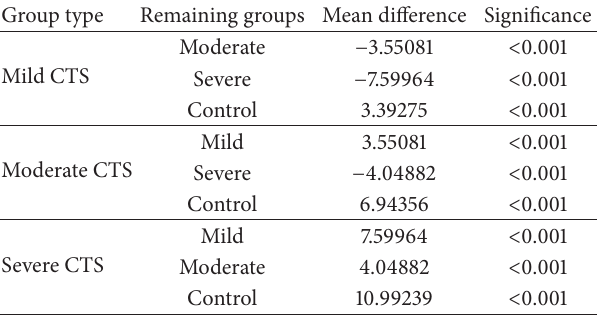
Table 4: Multiple comparisons of CSA of the MNs of different patientsubgroupswitheachotherandwiththatofthecontrolgroup. Group